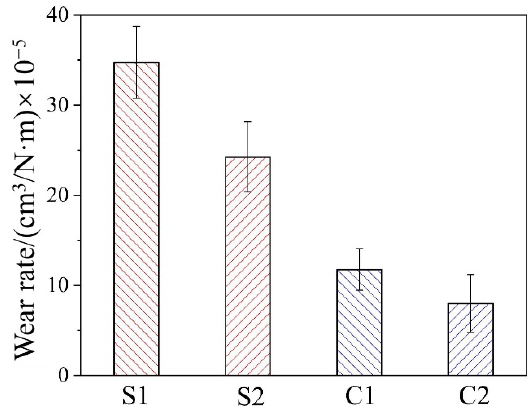
Figure 10. The wear rate of S1, S2, C1 and C2.